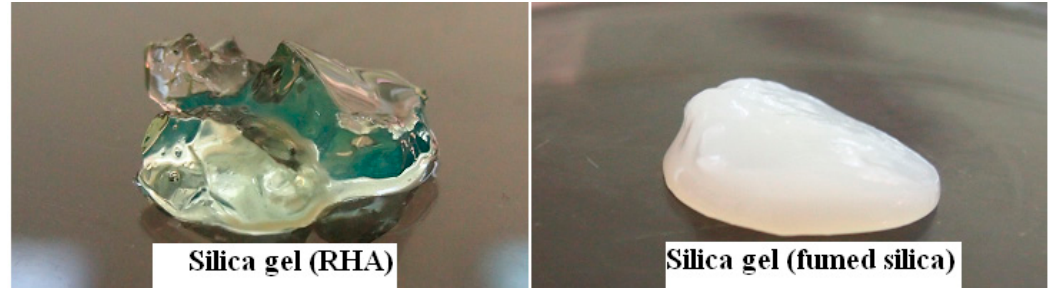
Figure 4. Digital images of gels from RHA ( left ) and fumed silica (FS) ( right ) as starting silica sources.